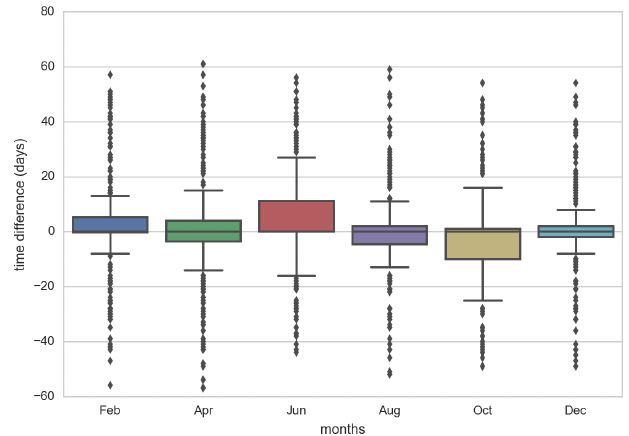
Figure 13. Boxplot for the time difference between revision and view